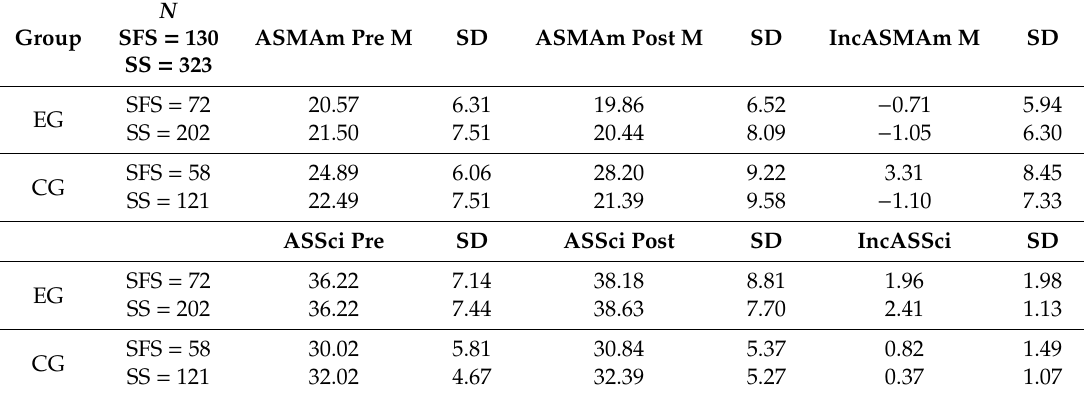
Table 5. Mean, M, and standard deviation, SD, of attitude towards mathematics and attitude towards school science for state-funded schools (SFS) and state schools (SS) in the experimental and control group. The increment for each is shown in the third column, IncASMAm and IncASSci. ( N = 274 for EG; N = 179 for